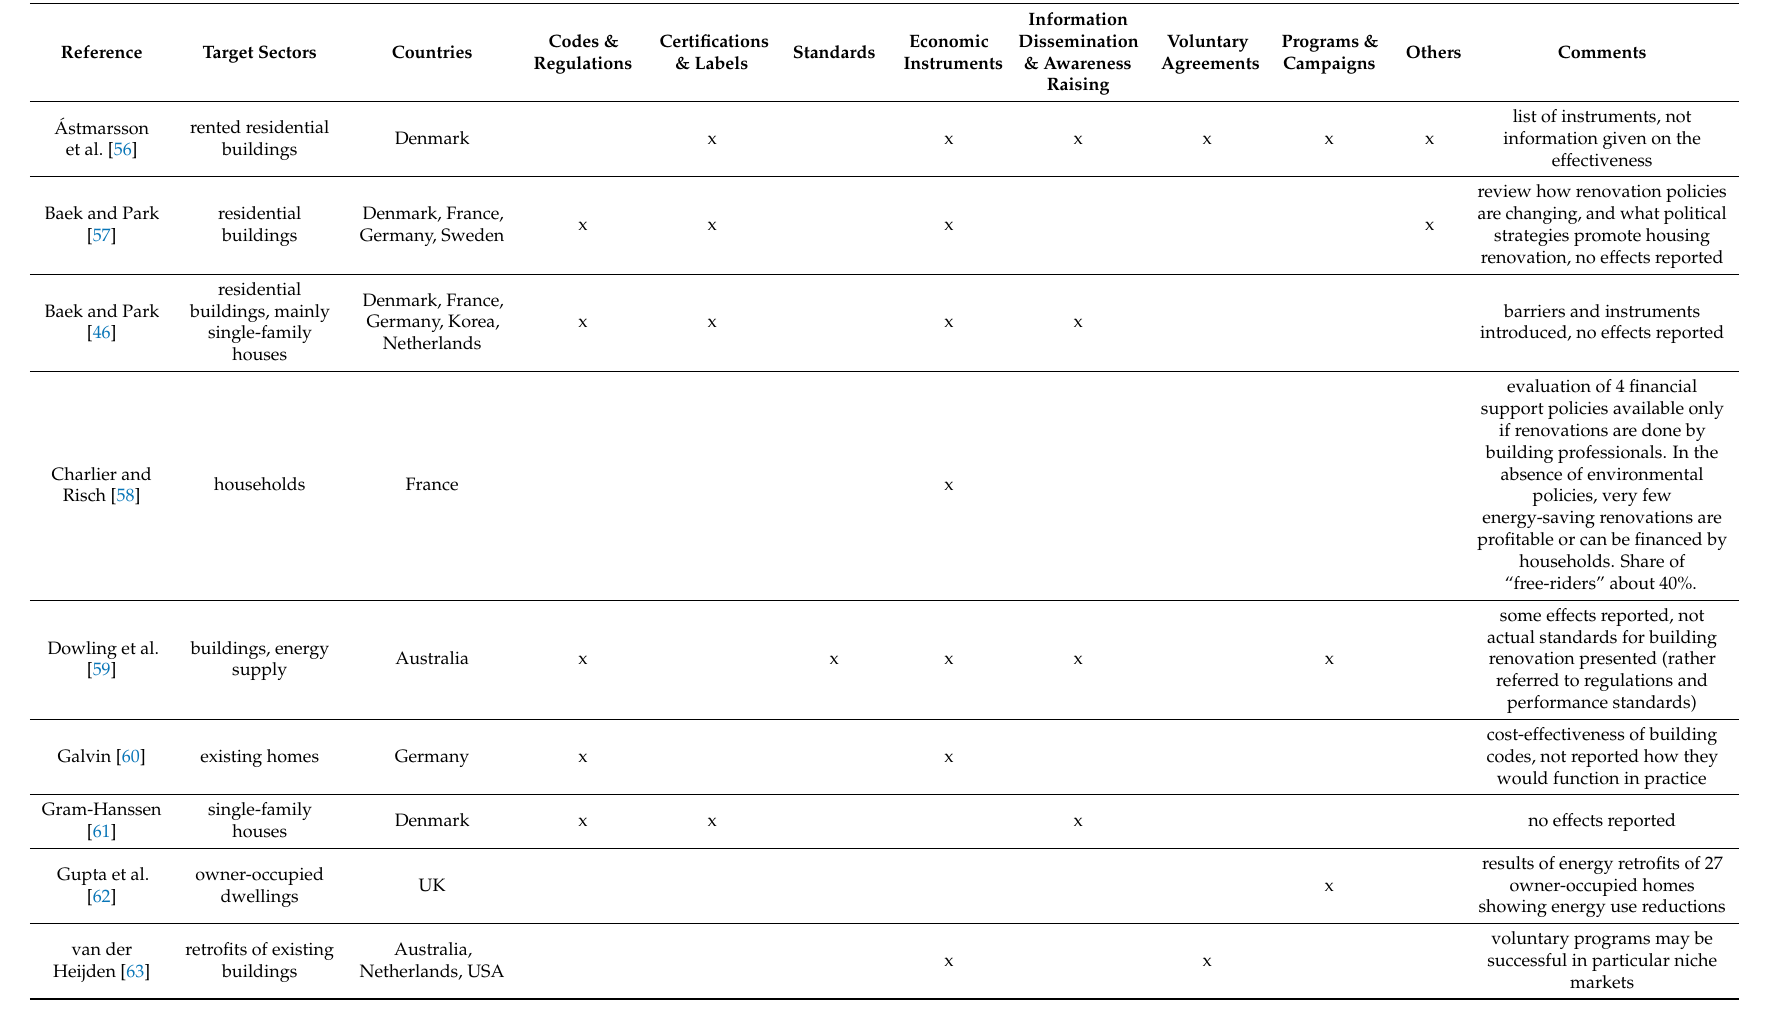
Table 1. Policy instruments addressed in renovation-related studies (may include other issues as